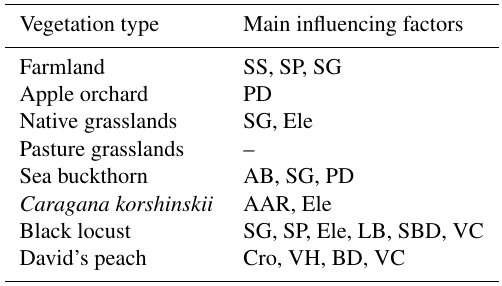
Table 3. Principal component analysis (PCA) of environmental at-